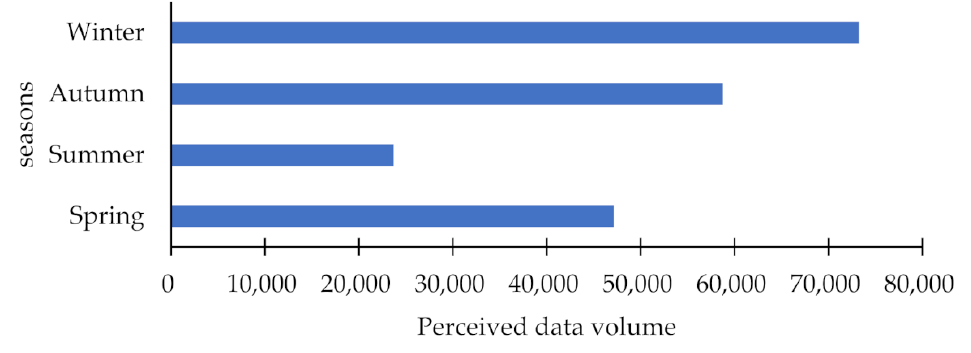
Figure 2. Amount of perceived data in the four